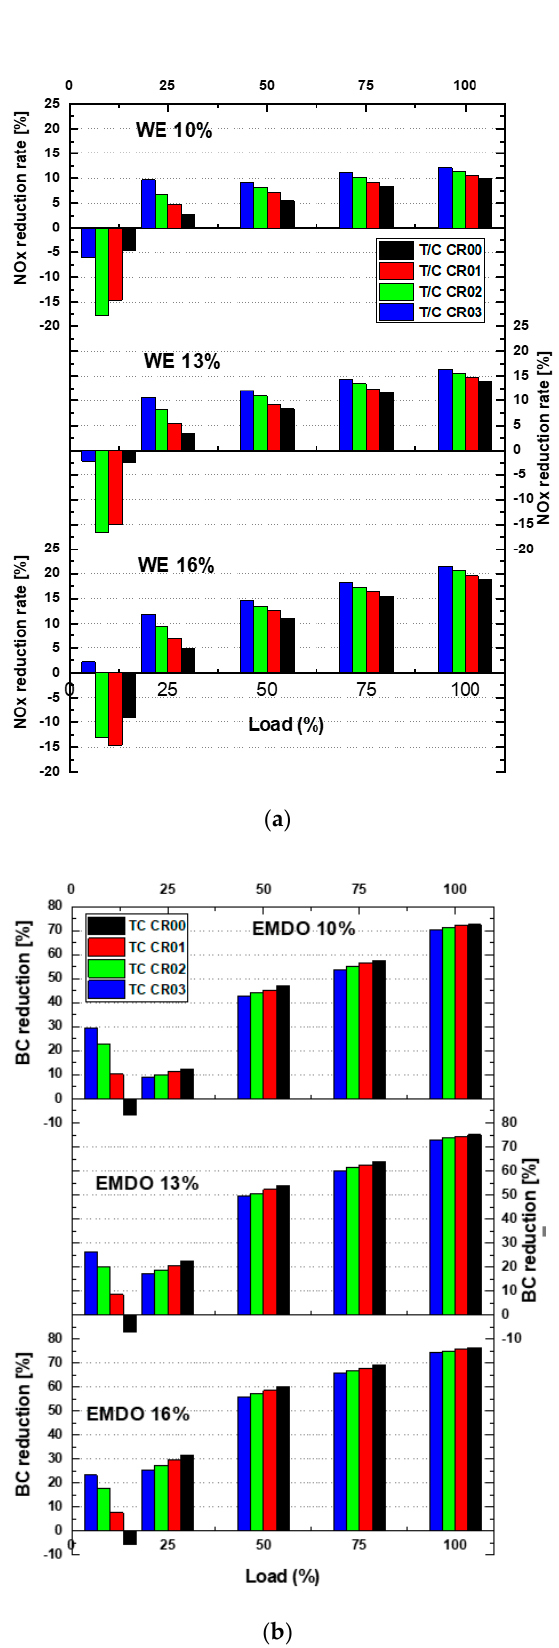
Figure 16. Reduction rate of NOx and black carbon versus turbocharger compression ratio and three types of emulsified marine diesel oil; ( a ) NOx emission, ( b ) black carbon emission.